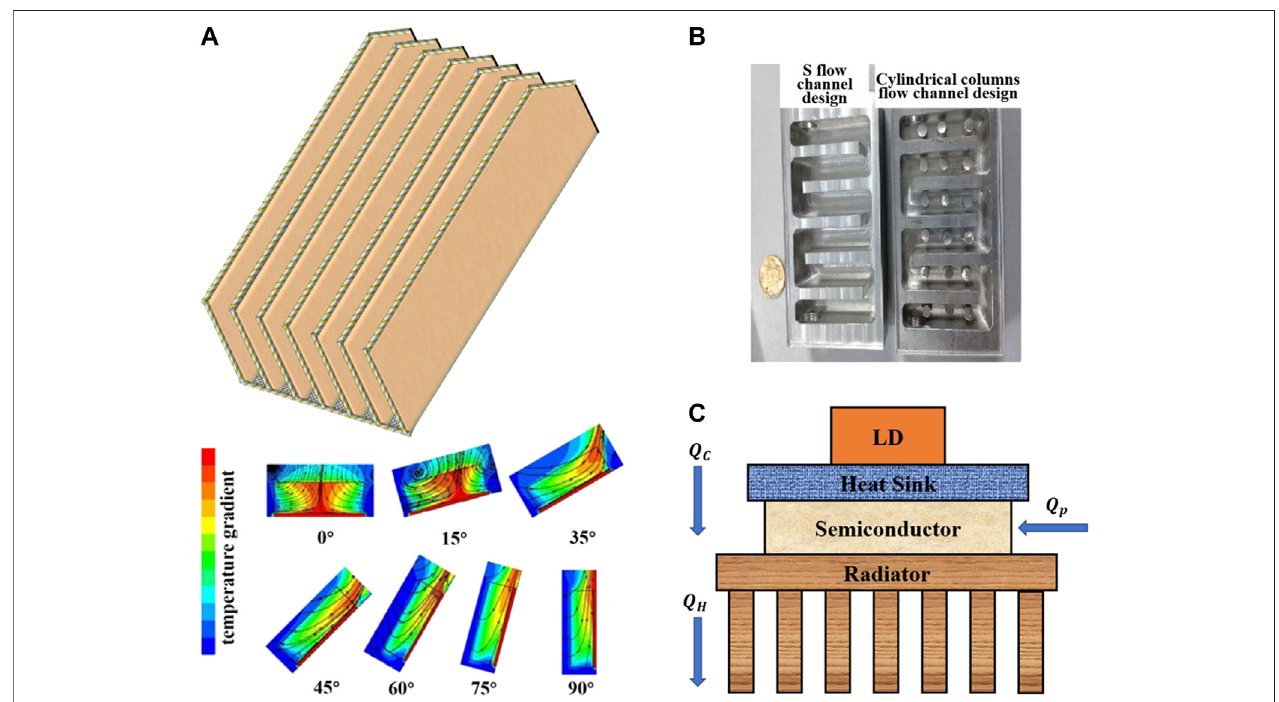
FIGURE 8 | Tradition heat dissipation methods: (A) schematic of cut corner heat sink and temperature distribution of heat sink fi ns at different installation angles. Adapted from [36]; (B) S-type with cylindrical spoiler large channel water cooling device. Adapted from [38]; (C) Schematic diagram of typical semiconductor cooling device. Adapted from